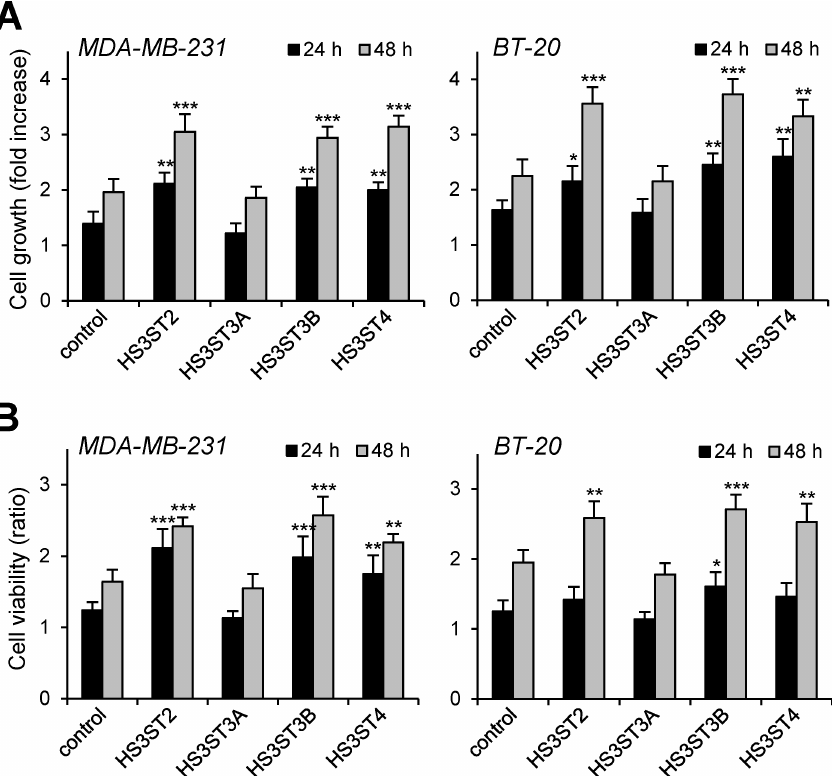
Fig 2. Effects of the expression of HS3ST2, HS3ST3A, HS3ST3B and HS3ST4 on breast cancer cell growth. MDA-MB-231 and BT-20 cells were transfected with overexpression vectors and cultured in medium containing 1% FCS for 24 h and 48 h. At each time, the effects of HS3STs on the growth of MDA-MB-231 and BT-20 cells was estimated by cell counting ( A ) and MTS assay ( B ). Results are expressed as fold changes by comparison with control cells transfected with empty vector. Data are means ± S.D. from three separate experiments performed independently ( (cid:3) P < 0.05, (cid:3)(cid:3) P < 0.01, (cid:3)(cid:3)(cid:3) P < 0.001, significantly different when compared to control cells).